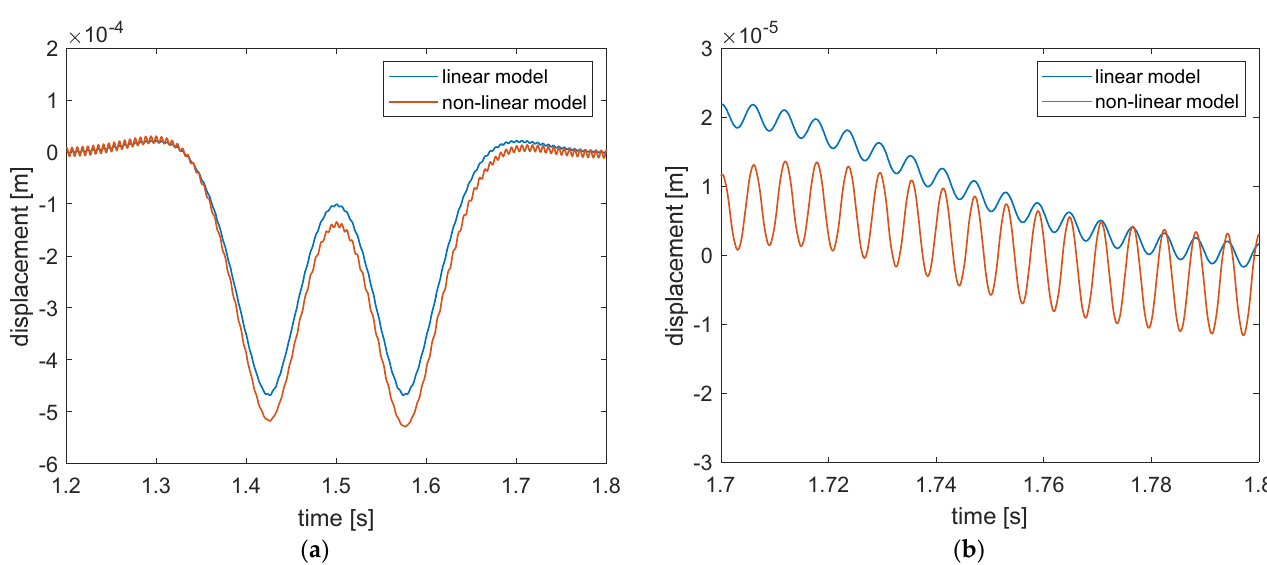
Figure 13. Rail responses predicted by the non-linear and linear models of unit length of the reference ERS subjected to a load simulating a train passage (ETR 500 coach at 72 km/h) and a dynamic force caused by a rail roughness with a wavelength of 120 mm (170 Hz) with an amplitude of 20 N: ( a ) time window of 1.2 ÷ 1.8 s (centred at the instant of the passage of a bogie); ( b ) time window of 1.7 ÷ 1.8 s (for a better visualisation of the high-frequency vibration).